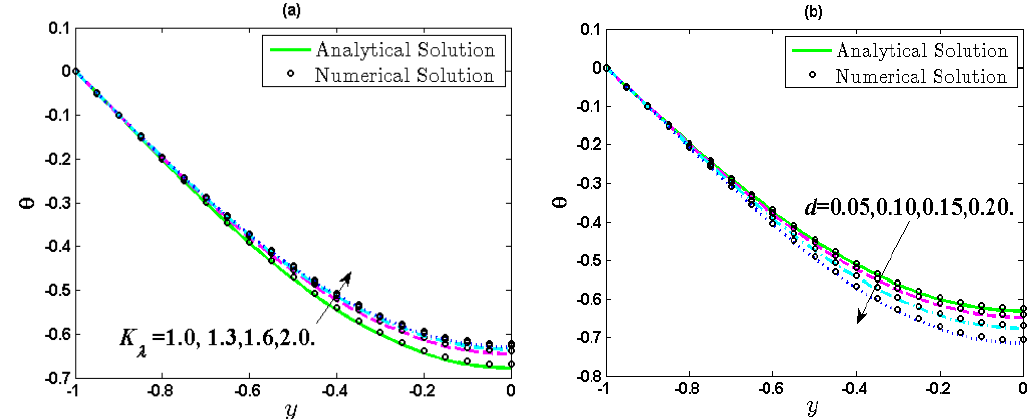
Figure 3. Distribution of temperature when λ = 0.25, R = 1, α = 1, u r = 0.1, Br = 0.01, J = 5. ( a ) Influence of K λ (1, 1.3, 1.6, 2) when d = 0.15; ( b ) Influence of d (0.05, 0.10, 0.15, 0.20) when K λ = 1.